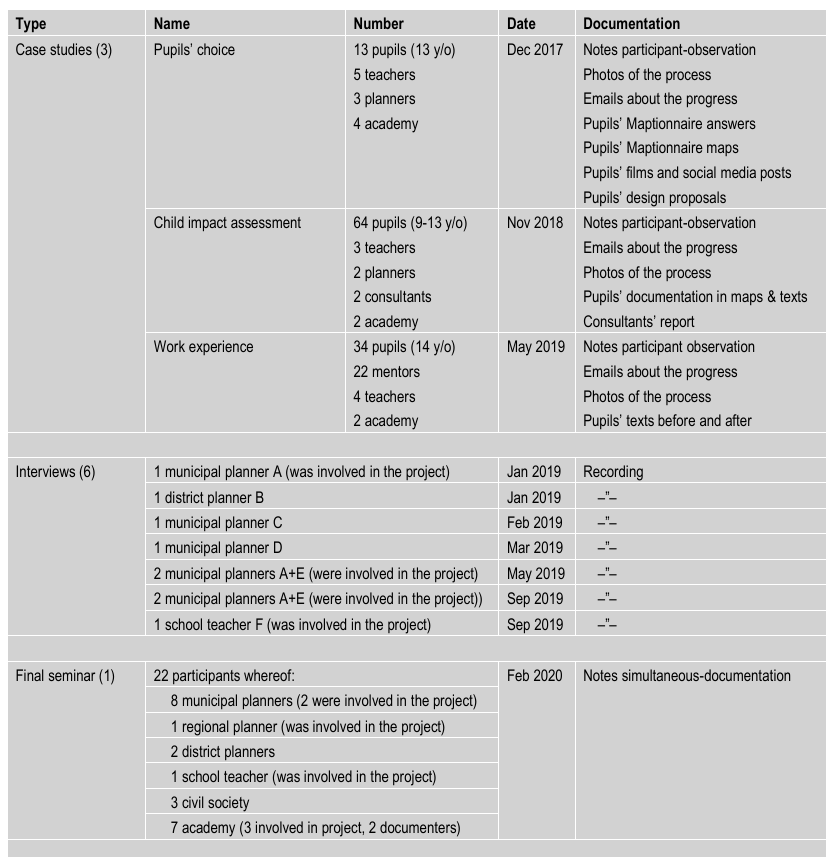
Figure 1. Picture of the project’s empirical